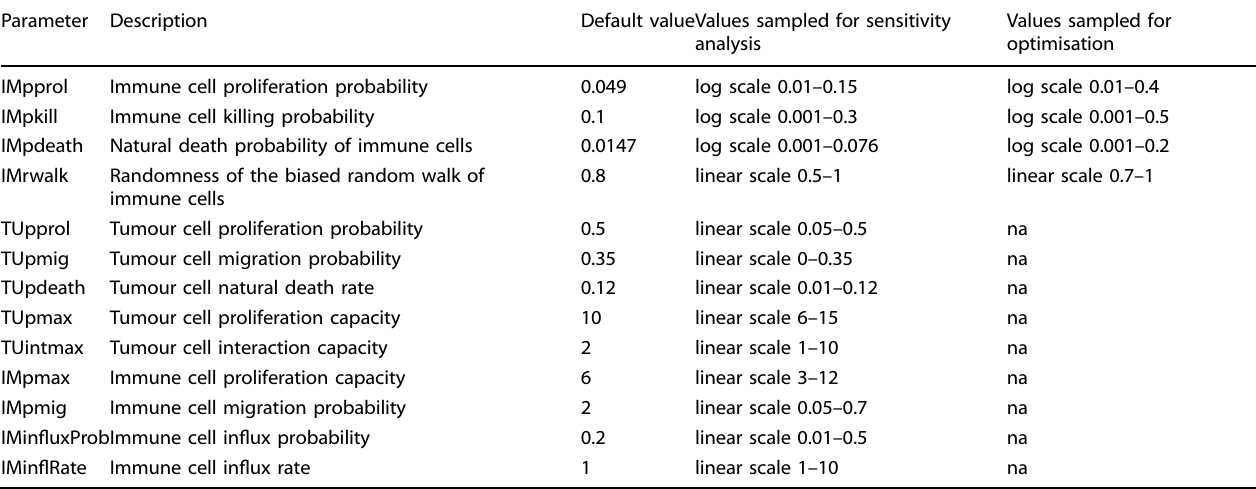
Table 4. Parameter names, descriptions and ranges scanned for the sensitivity analysis and optimisation steps. Parameter